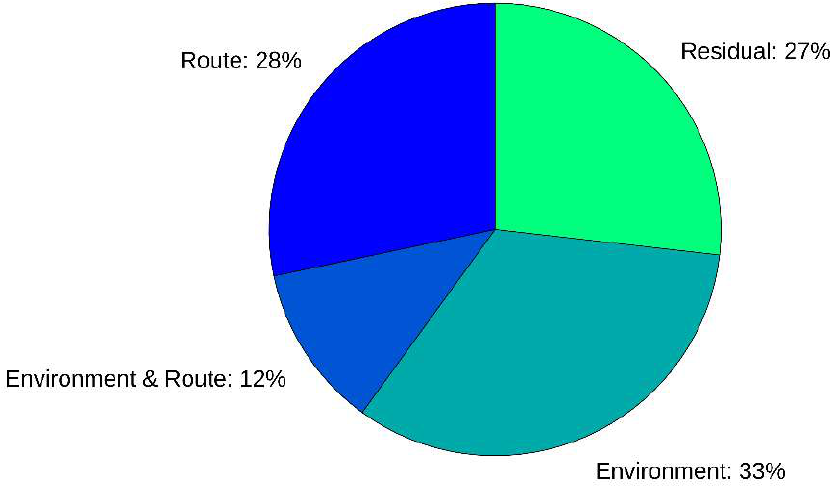
Figure 18. Variance decomposition of the ECR variation.